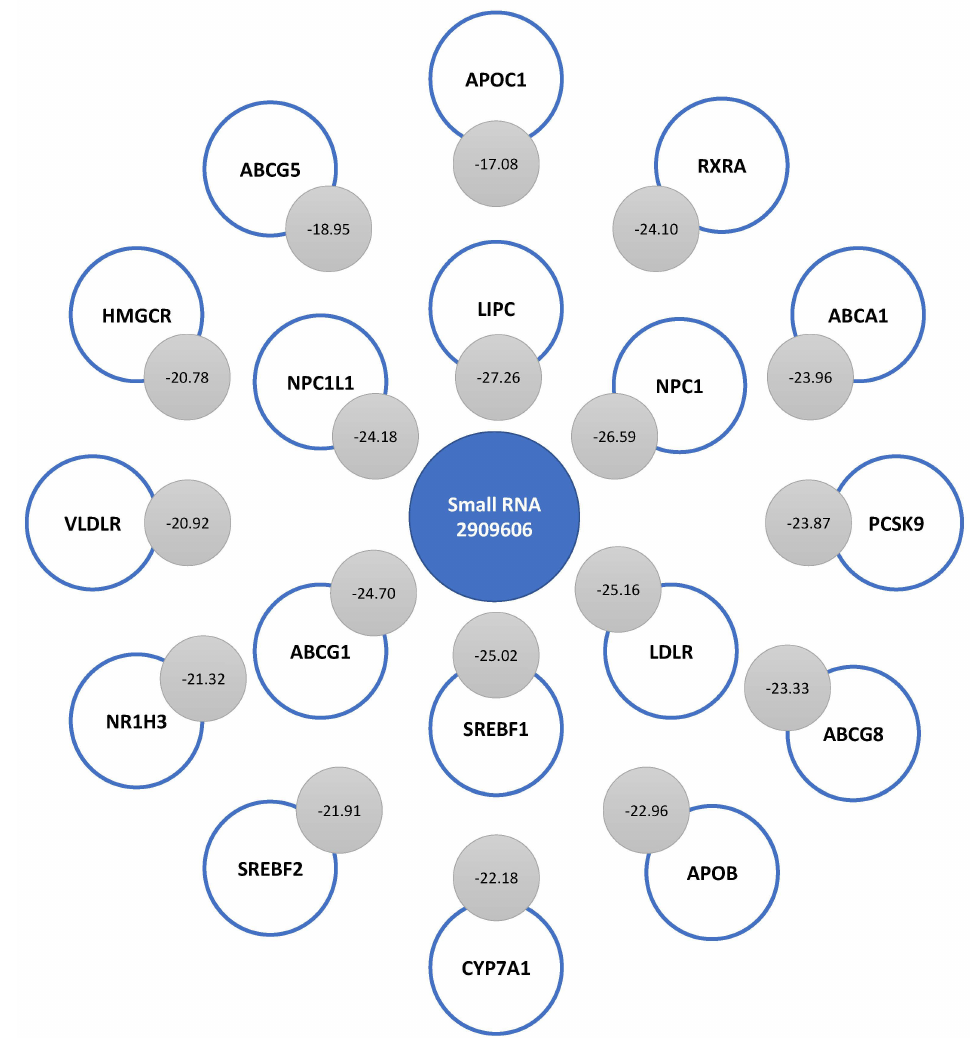
Figure 6. Complementarity of the sequence of small RNA 2909606 with 18 mRNAs of genes involved in cholesterol metabolism. The binding energy levels associated with each interaction are indicated in the gray